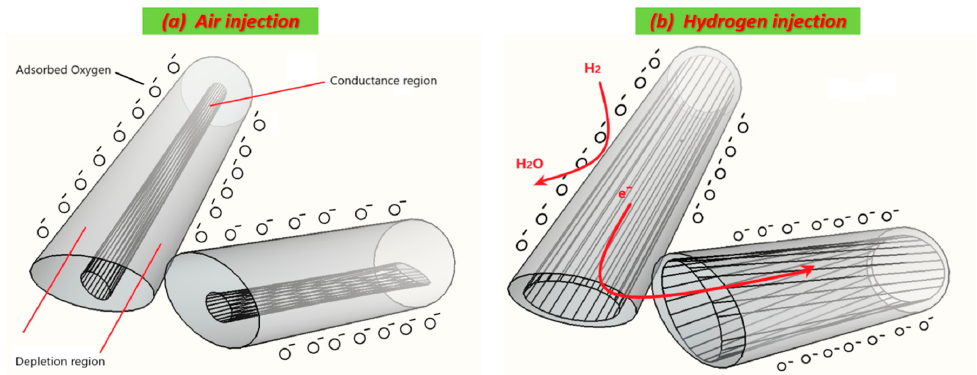
Figure 5. Hydrogen-sensing mechanism model of one -dimensional (1-D) sensor: ( a ) charge transfer and air injection; ( b ) sensing model toward hydrogen.